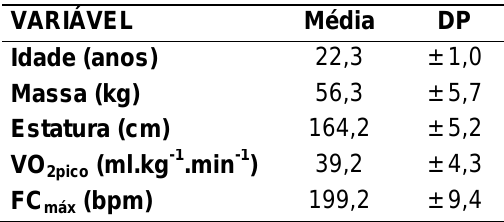
A partir dessas variáveis, foram calculados